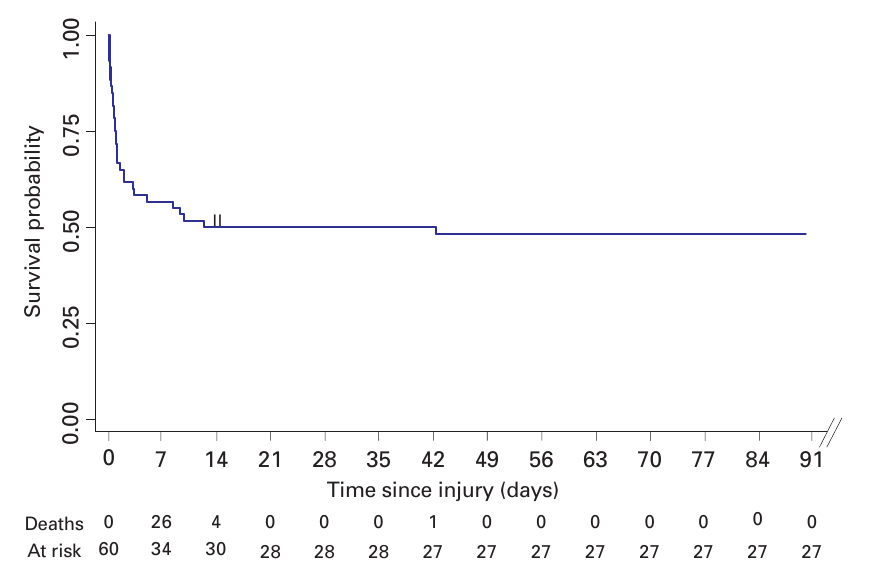
48 patients: the median was 51 (range